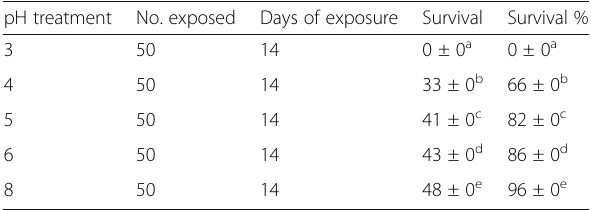
Table 3 Mean survival of O. niloticus adults in low pH and control